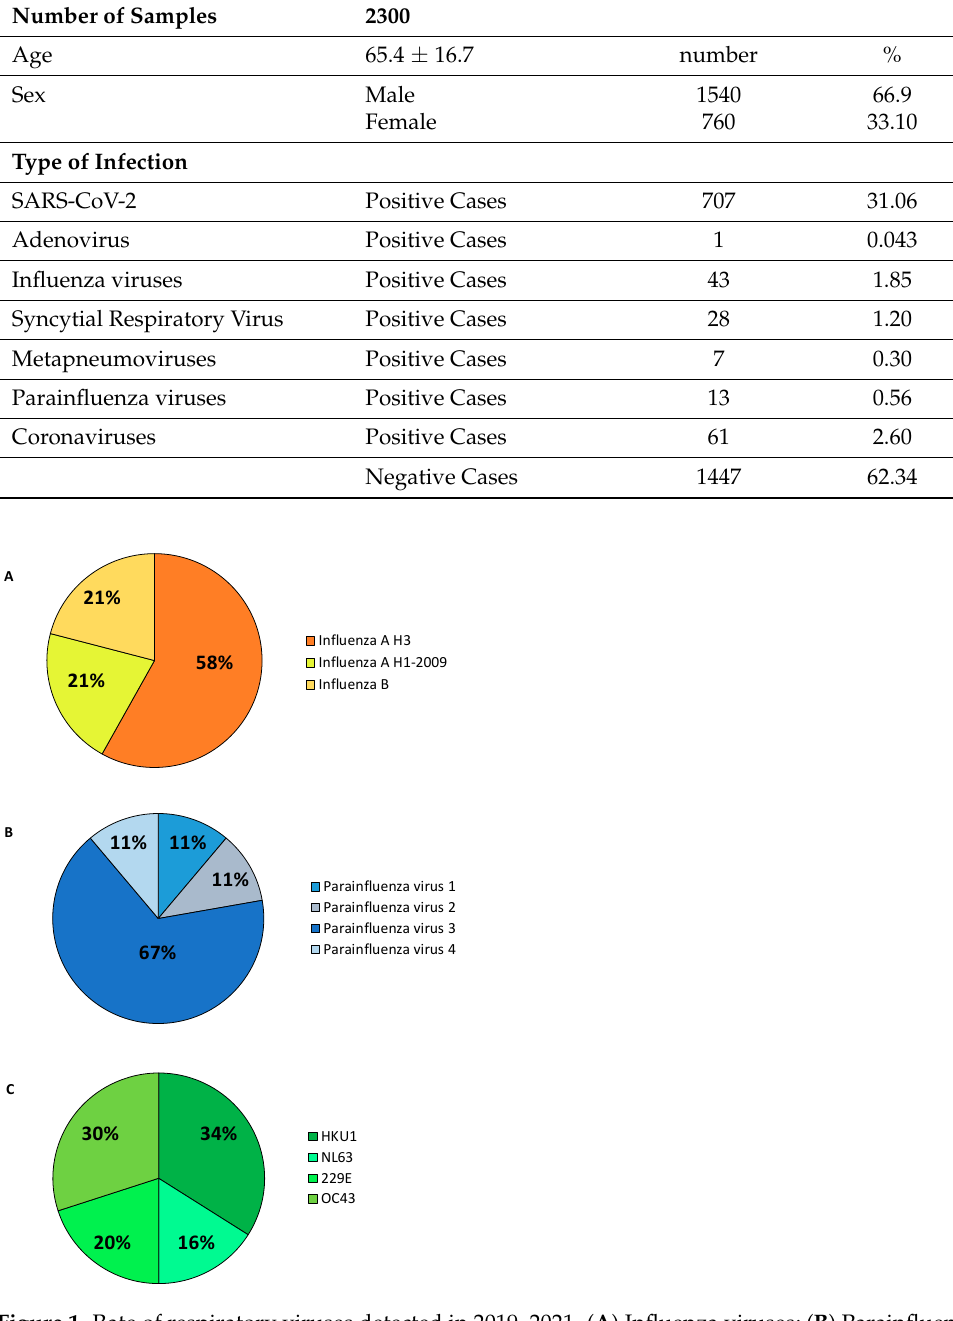
Figure 1. Rate of respiratory viruses detected in 2019–2021. ( A ) Influenza viruses; ( B ) Parainfluenza viruses; and ( C ) Coronaviruses.